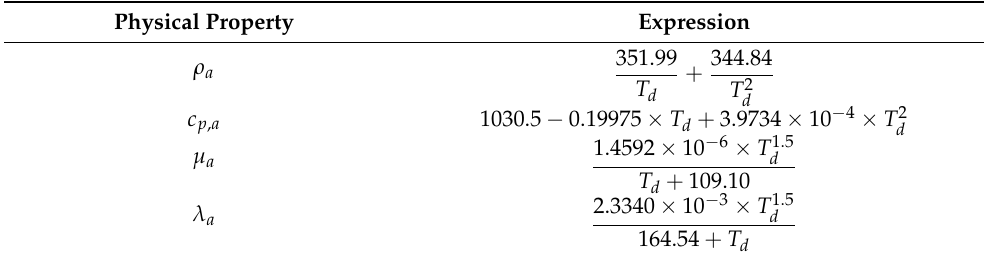
Table A1. Thermophysical properties of dry air for the temperature range between 200K and 400K at 1